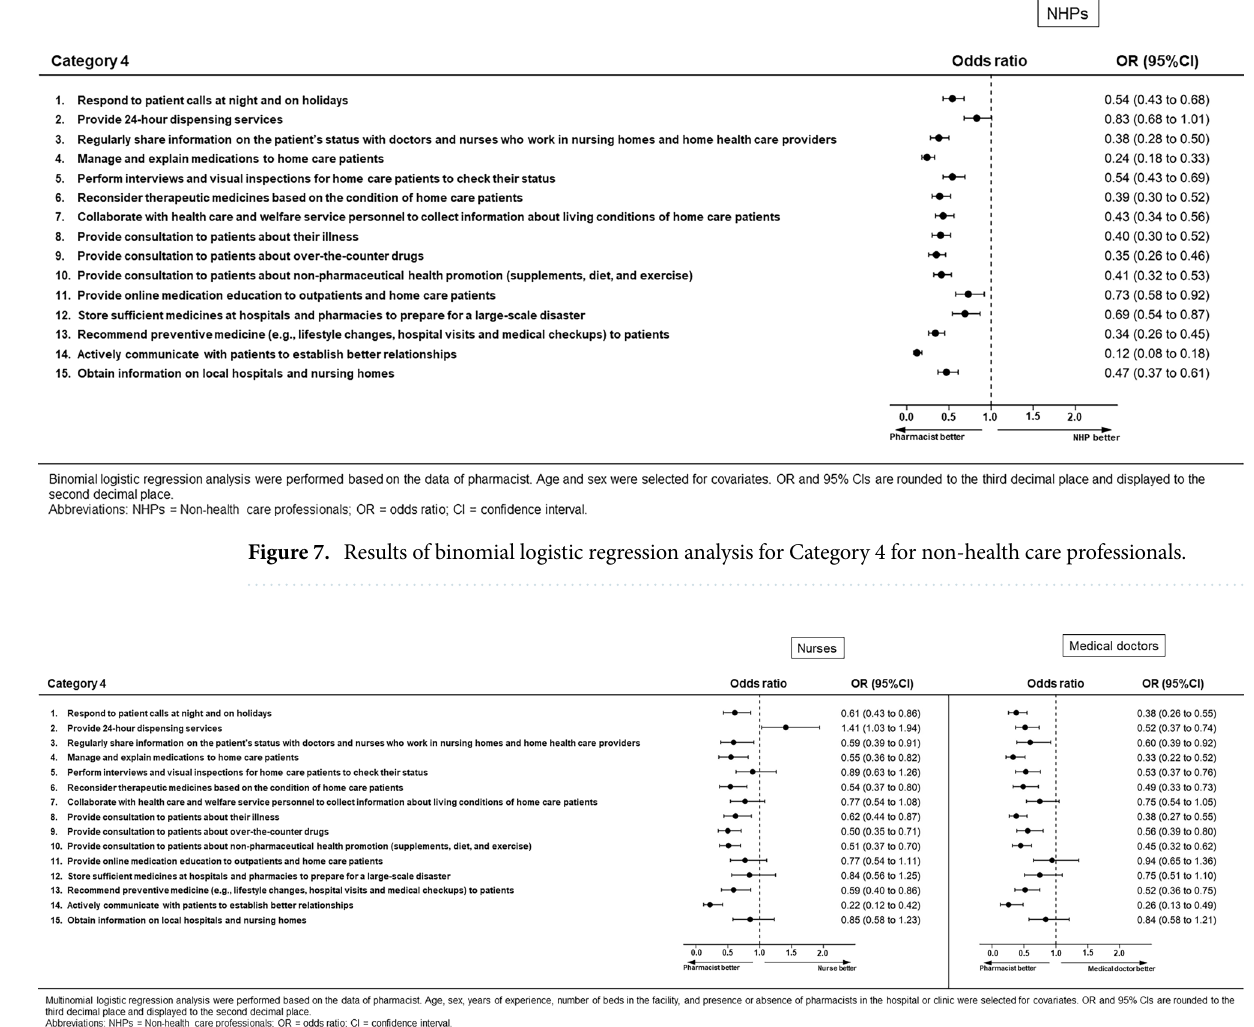
Figure 8. Results of multinomial logistic regression analysis for Category 4 for nurses or